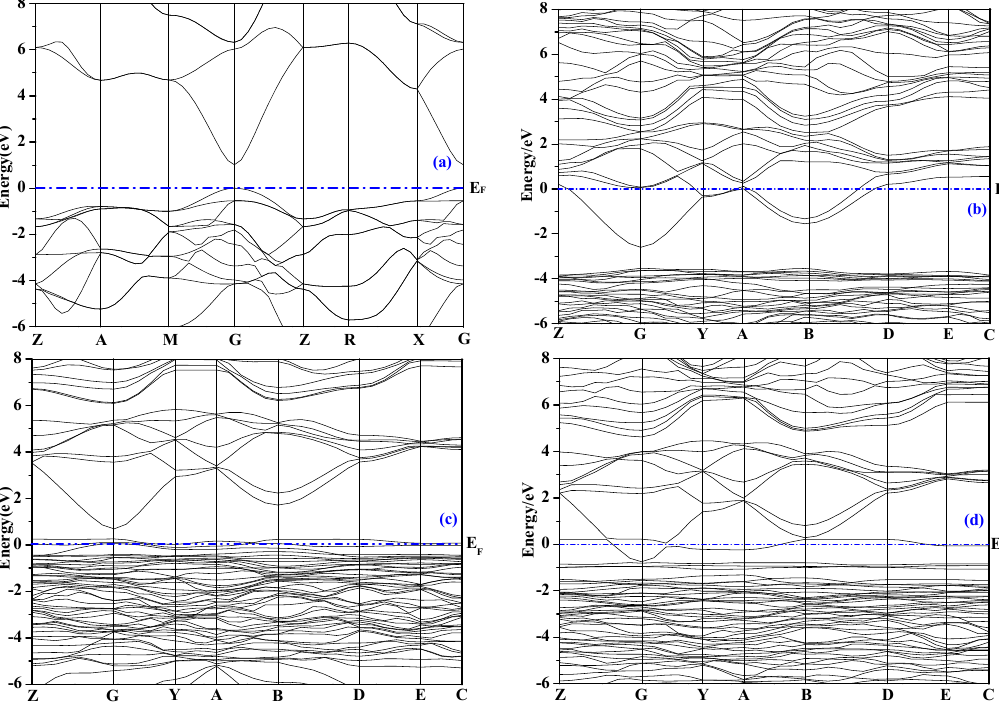
Figure 2. Energy band structure: ( a ) SnO 2 ; ( b ) SnO 2 -F; ( c ) SnO 2 -Cu; ( d ) SnO 2 -Cu-F.